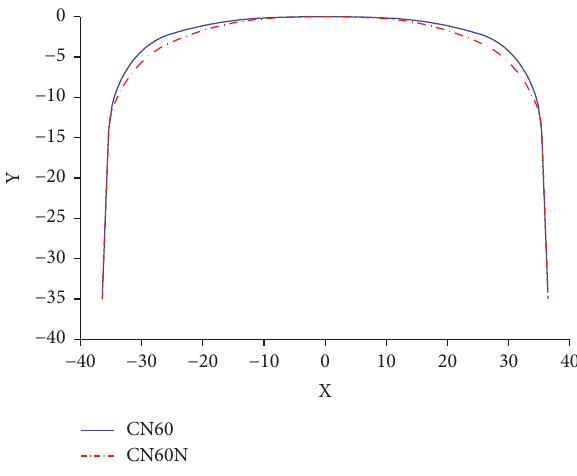
Figure 11: Rail tread (unit: mm).